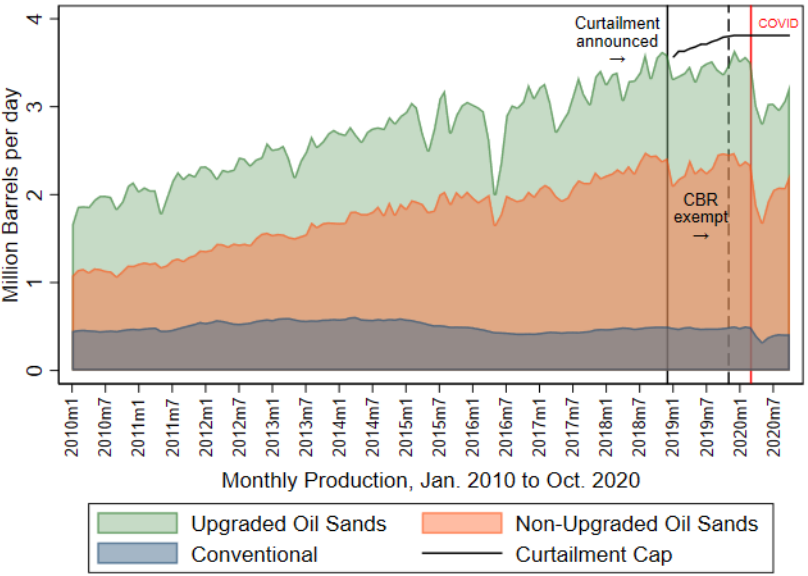
Figure 5. Monthly Crude Oil Production, 2010–2020 [26]. Monthly crude oil production from conventional wells, oil sands, and upgraded oil sands. Excludes condensate. “CBR” is crude by rail, which became exempt from curtailment on 28 October 2019. See Figure 2 for the full curtailment timeline. The large dip in production in March 2016 is the Fort McMurray fire, and the dip in March 2017 is the explosion at the Syncrude oil sands